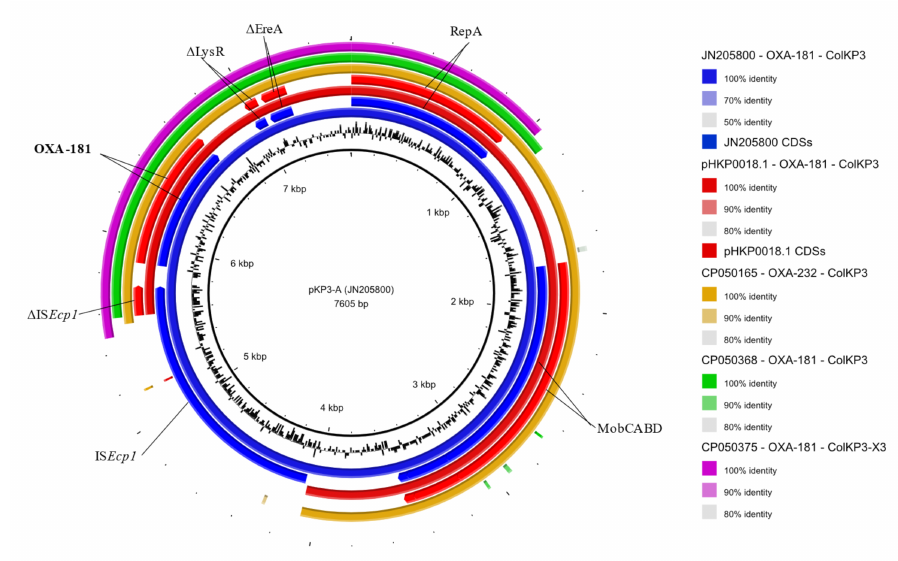
Figure 2. Graphical representation of bla OXA-181 / bla OXA-232 -carrying plasmids sequence comparison. Starting from the inner ring: GC content of pKP3-A plasmid sequenced (here used as reference), bla OXA-181 -positive pKP3-A plasmid sequence (JN205800), pKP3-A CDSs, bla OXA-181 -positive pHKP0018.1 plasmid sequence (CP061063.1), pHKP0018.1 CDSs, bla OXA-232- positive Carbapenemase (OXA-232)_ColKP3 plasmid sequence (CP050165), bla OXA-181 -positive p47733_OXA_181 plasmid sequence (CP050368), bla OXA-181 -positive p50595_OXA_181 plasmid sequence (CP050375). CDS’s arrows indicate their transcription direction. Hypothetical proteins are not displayed. The figure was generated with BRIG